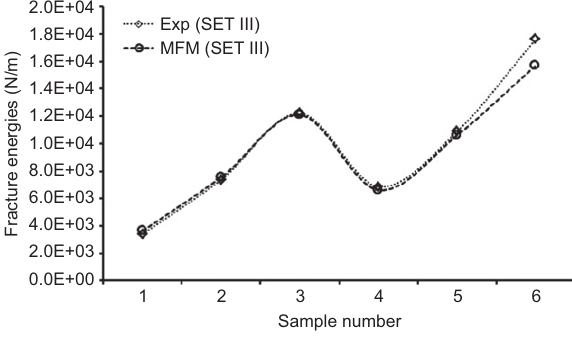
Figure 6 Comparison of the experimental and FL results according to the sample numbers (SET I).